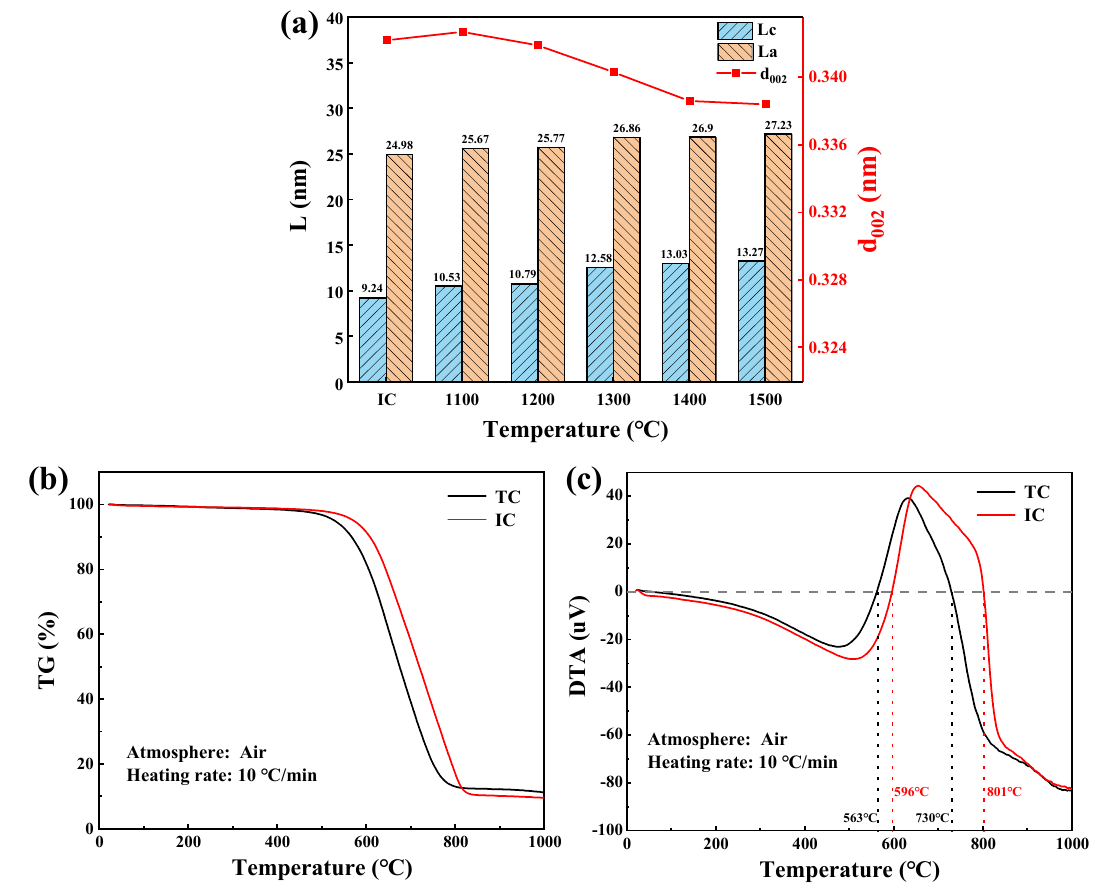
Figure 3. ( a ) Variation trends of coke microcrystal parameters at different temperatures. ( b , c ) TG-DTA curves of TC and IC.